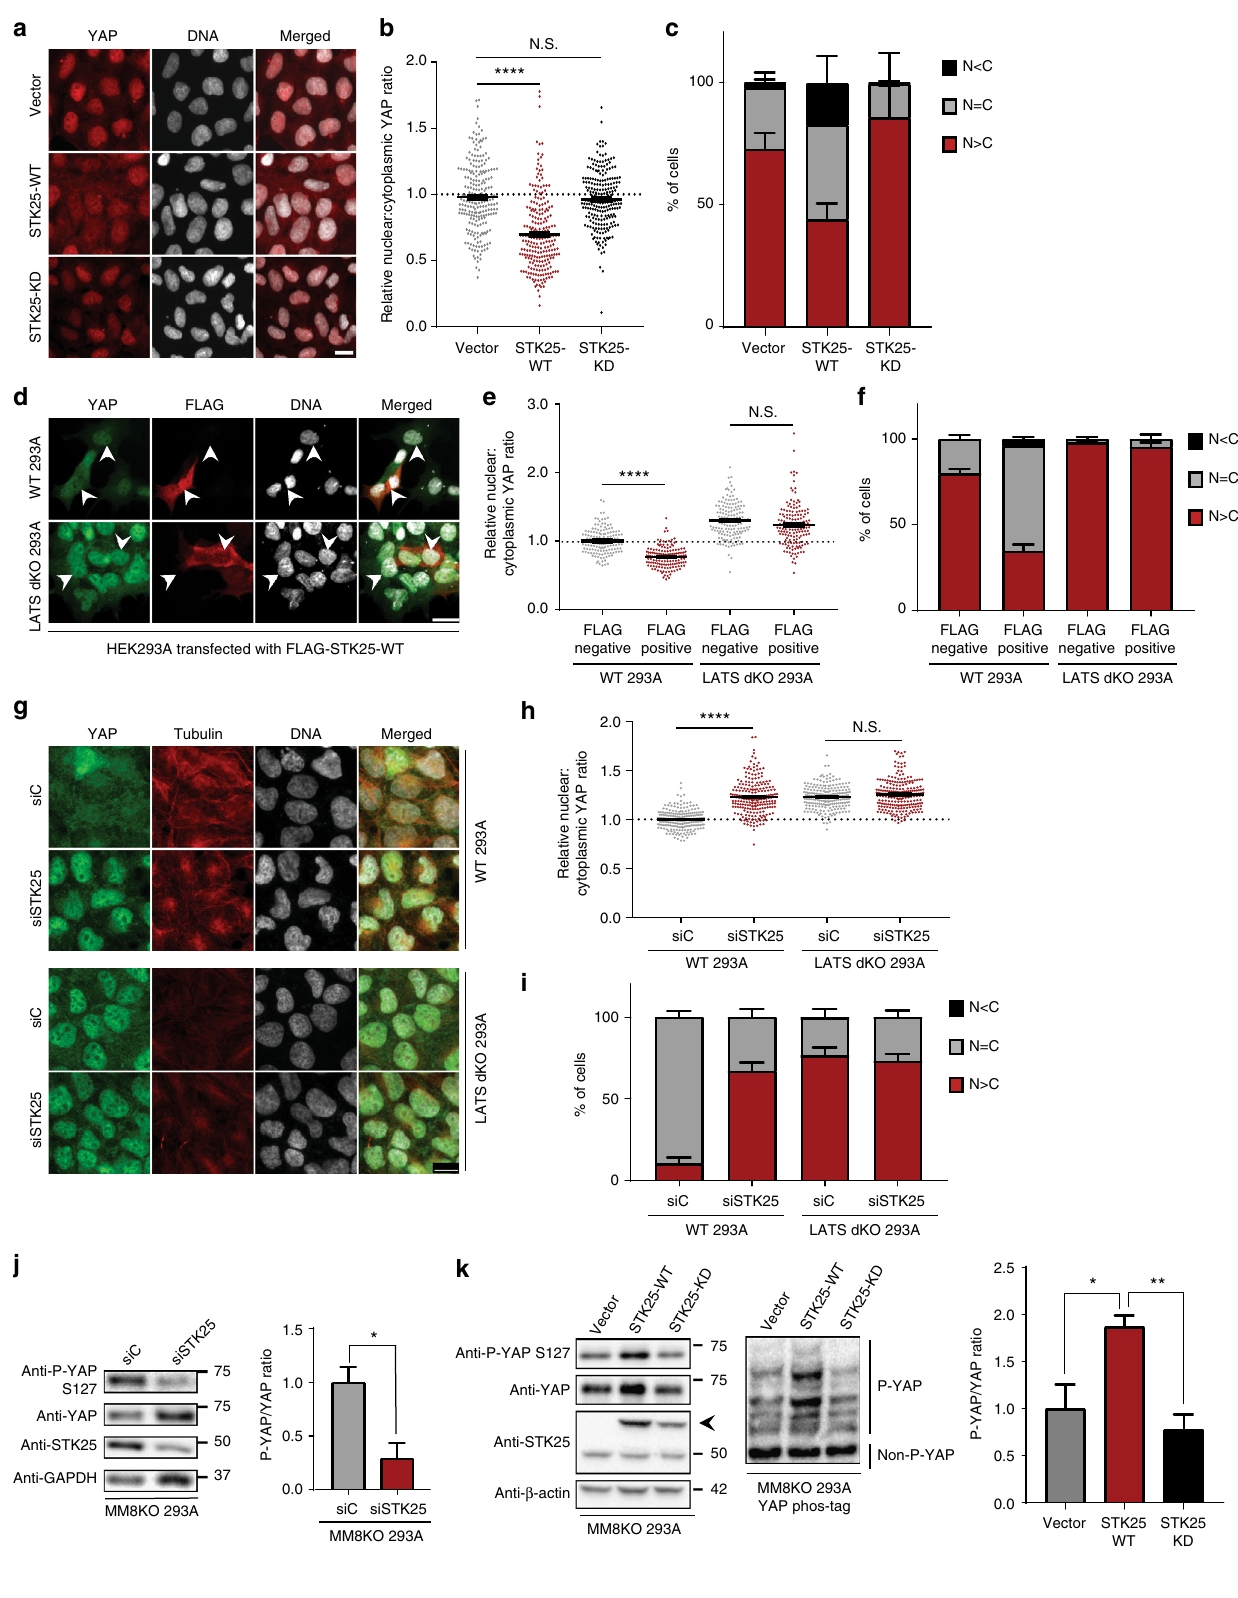
LATS intrinsic kinase activity (Supplementary Fig. 4b). As expected, we found that while MAP4K1 was able to promote phosphorylation of kinase-dead LATS2 at the hydrophobic